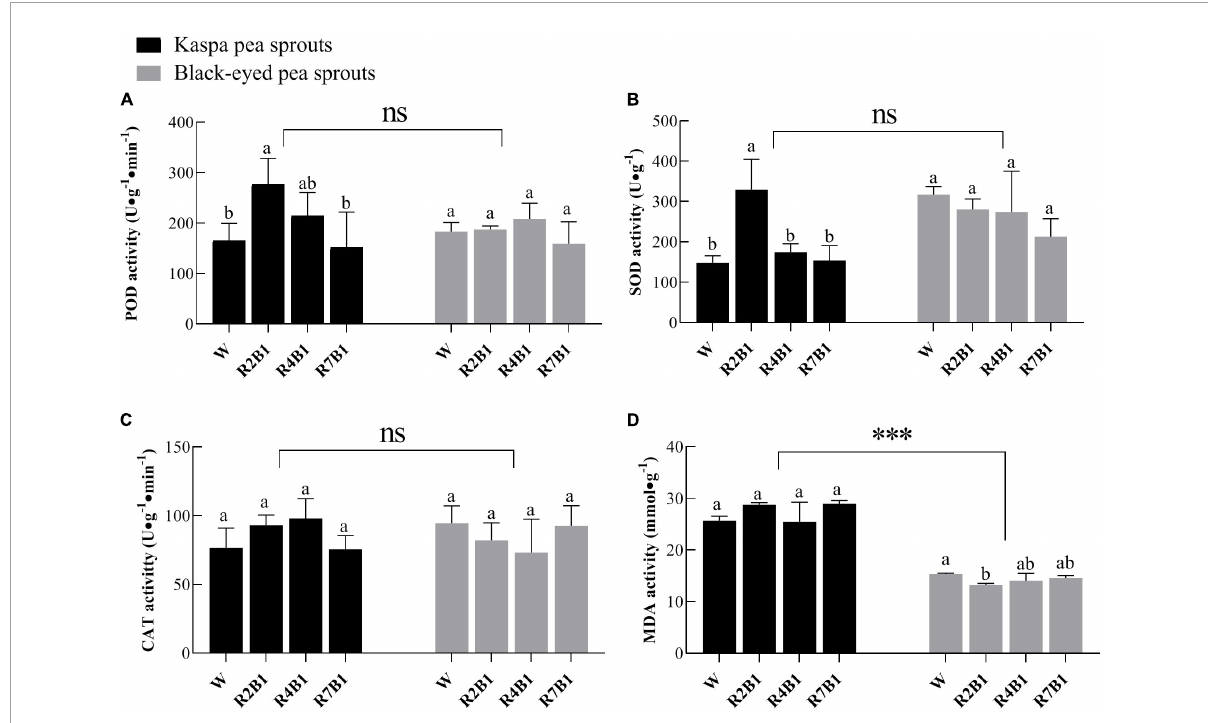
FIGURE3 Effects of four LEDs’ light quality combinations on antioxidant capacity of two cultivars of pea sprouts. (A) Peroxidase (POD) activity; (B) superoxide dismutase (SOD) activity; (C) catalase (CAT) activity; (D) malondialdehyde (MDA) content. Different letters indicate significant differences at P ≤ 0.05 of the same variety among treatments. ∗∗∗ Denotes significant differences at P ≤ 0.001 of different varieties, and ns means no significant difference. Error bars represent six